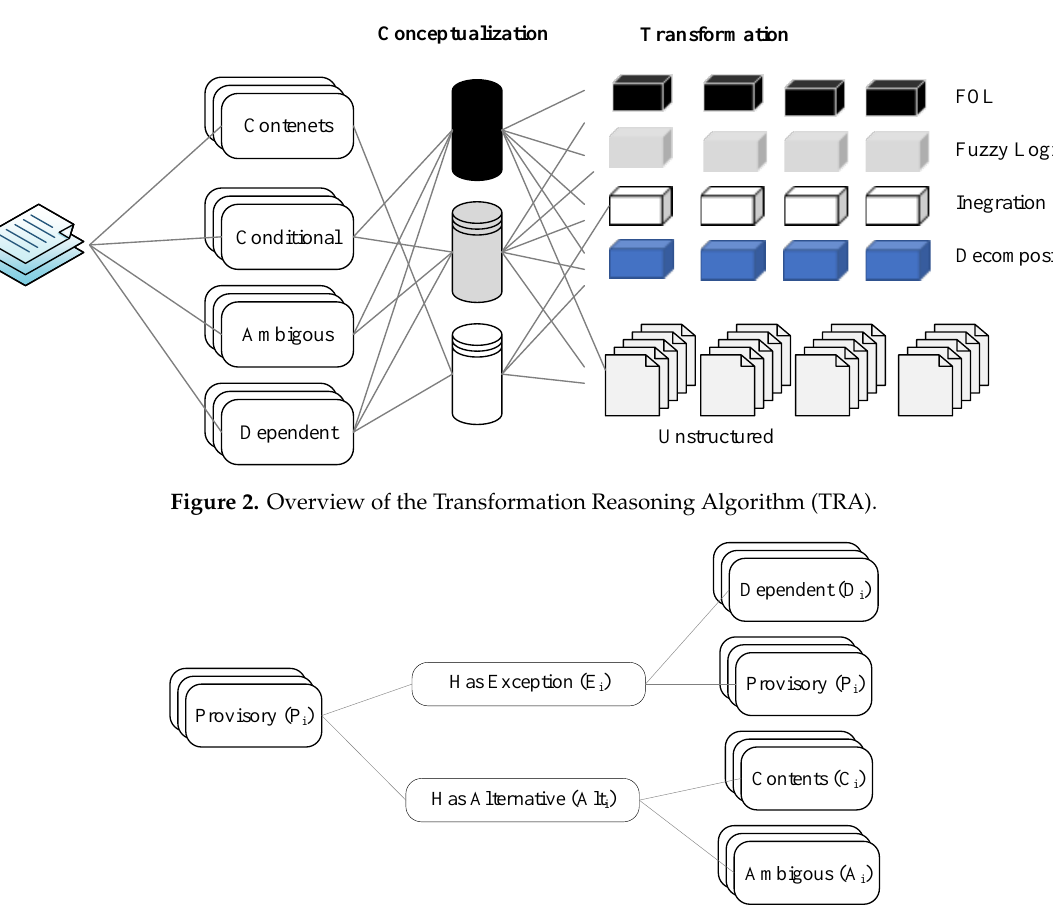
Table 1. The syntax of the Transformation Reasoning Algorithm (TRA).